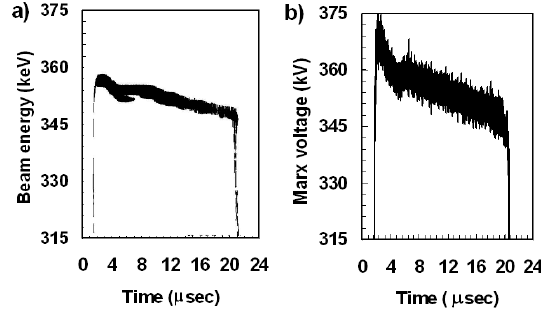
FIG. 4. (a) Longitudinal time-energy phase space as measured using the EEA with the helix unpowered. (b) Marx voltage